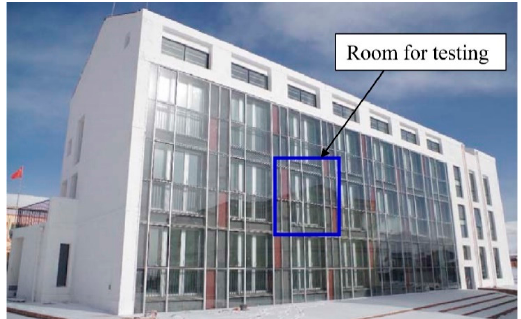
Figure 4. Heat balance solution procedure for the building with the HHCF.